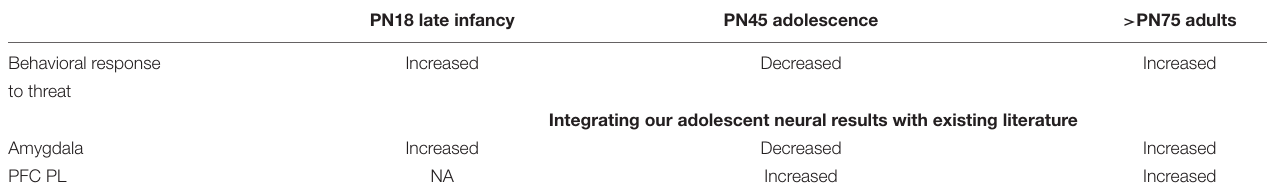
FIGURE 4 | Amygdala and prefrontal cortex activation following memory retrieval at 24 h in adolescent animals. (A) Amygdala subnuclei activation following fear retrieval at 24 h in both control (black) and abused (red) animals; LA: lateral nucleus, B: basal nucleus, CeA: central nucleus, CoA: cortical nucleus, and MeA: medial nucleus. (B) Prefrontal cortex activation following fear memory retrieval at 24 h in both normal (black) and abused (red) animals; PL: prelimbic cortex, IL: infralimibic cortex. (C,D) Bivariate correlation matrices were contructed across regions assessed for c-Fos levels after cue test during adolescents following control or low bedding rearing. White squares denote example nodules (groups of regions) that show dramatic changes in connectivity across condition. Color bar shows Pearson’s r values with positive correlations in red and negative correlations in blue. For statistical comparisons, r values were converted to z scores via Fisher transform and compared using ANOVA. Asterisks indicate pairwise correlations that significantly differed between LB and control. ∗ p < 0.05, ∗∗ p < 0.01, ∗∗∗ p < 0.001, and # p = 0.05. TABLE 1 | Summary of the developmental neurobehavioral response to threat to a across development after experiencing infant